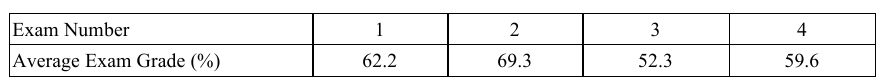
Table 5. Average exam grade for each